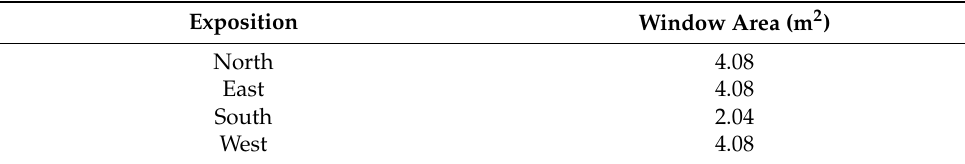
Figure 1. Layout of the single-family house analyzed. Table 1. Window area by exposition for the single-family house.